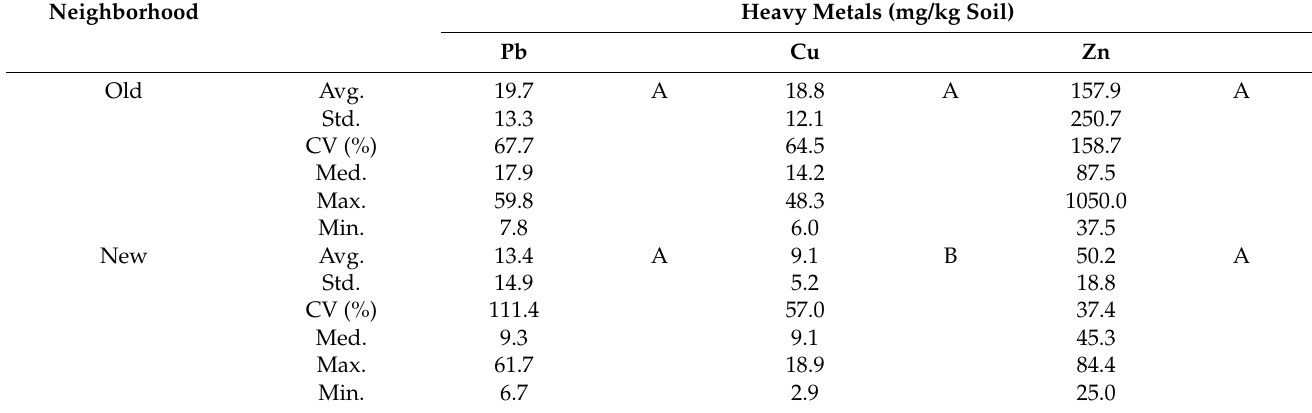
Table 3. Statistical parameters of lead (Pb), copper (Cu), and zinc (Zn) at 0–2 soil depth in the gardens of both city neighborhoods. N = 15 for each metal in each neighborhood. For each soil’s heavy metals, different letters indicate significant difference between the neighborhoods by Duncan’s multiple range test at P =